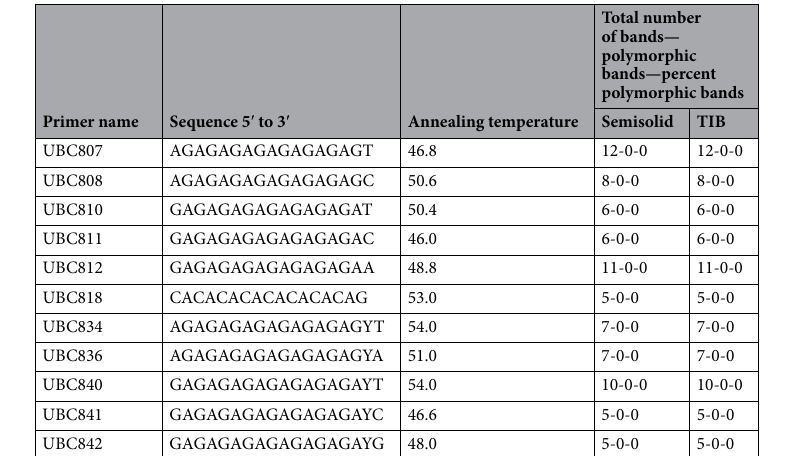
Table 3. List of ISSR primers used for assessment of genetic fidelity.